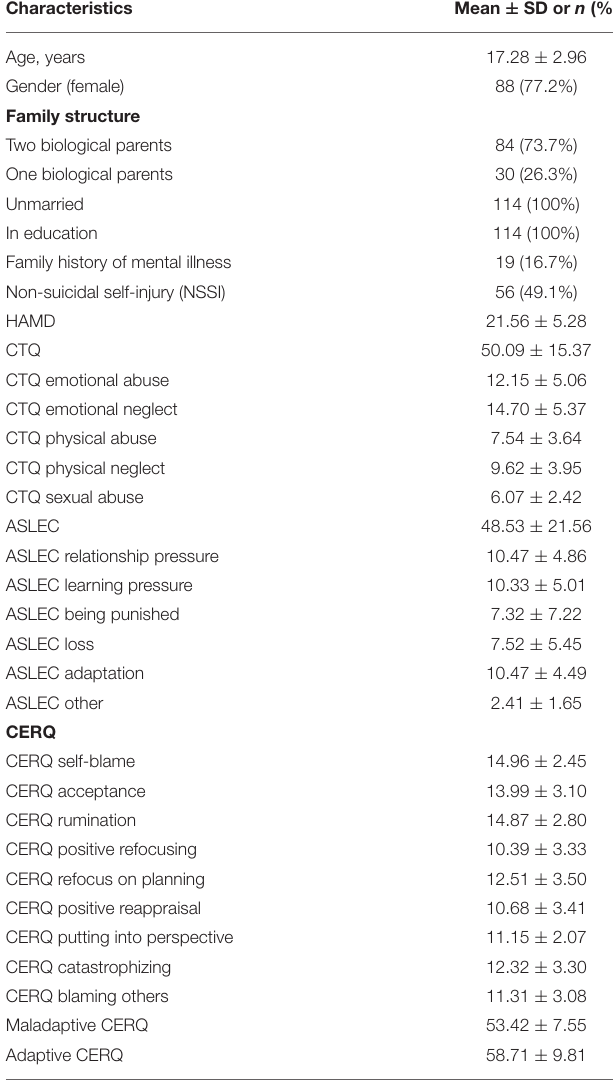
TABLE 1 | Demographic and clinical characteristics of patients with MDD ( n =